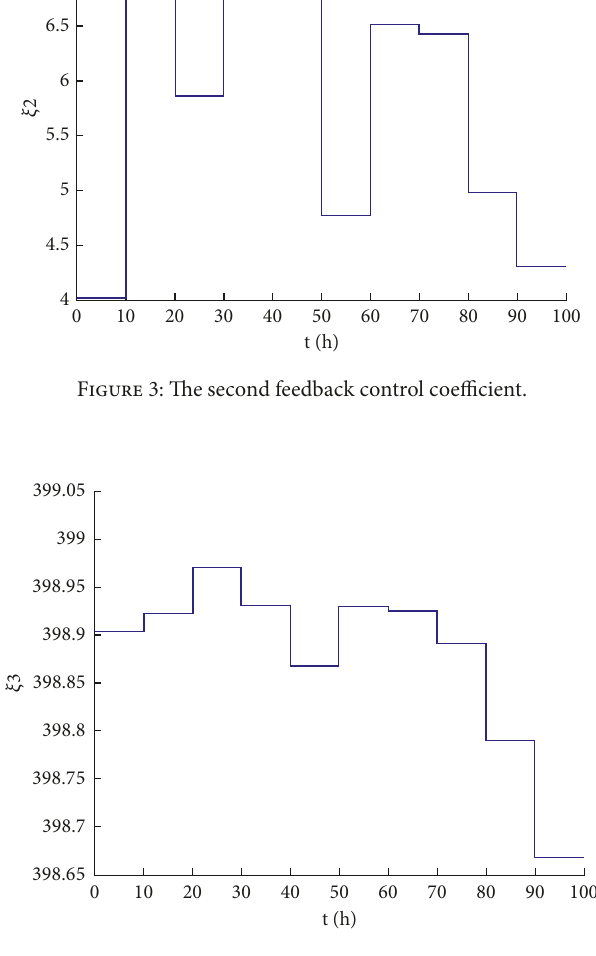
Figure 4: The third feedback control coefficient.